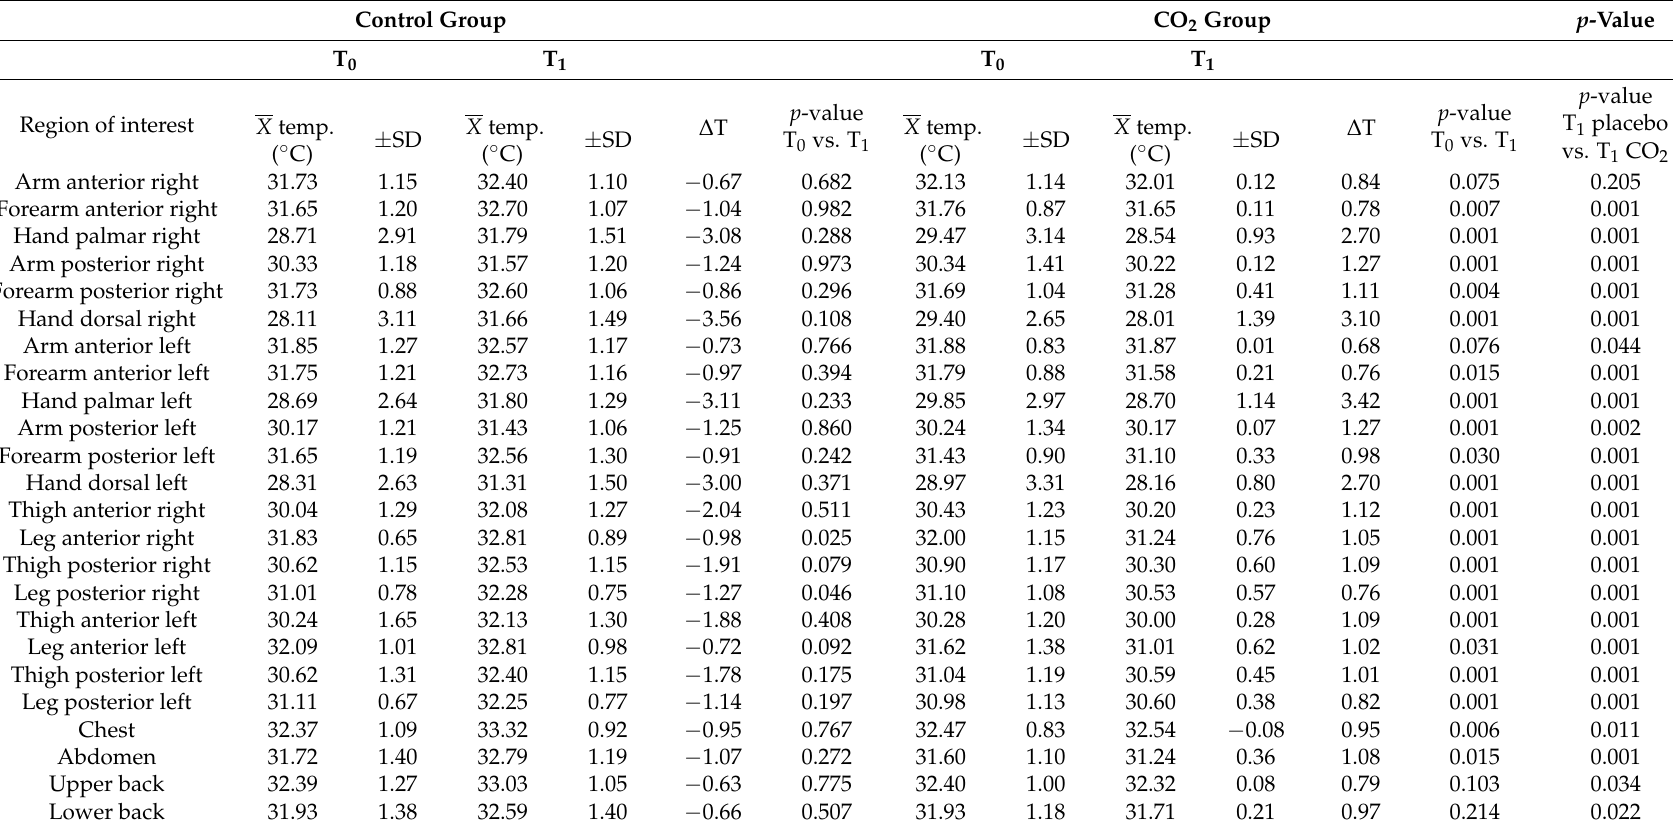
Table 3. Results of tests of statistical surface temperatures of selected region of interest (ROI) during T 0 and T 1 for the study group and the control group. Control Group CO 2 Group p -Value T 0 T 1 T 0 T 1 p -value p -value ∆ T p -value T 1 placebo Region of interest ∆ T X temp. X temp. X temp. X temp. ± SD ± SD ± SD ± SD T 0 vs. T 1 T 0 vs. T 1 vs. T 1 CO 2 ( ◦ C) ( ◦ C) ( ◦ C) ( ◦ C) Arm anterior right 31.73 0.205 Forearm anterior right 31.65 0.001 Hand palmar right 28.71 0.001 Arm posterior right 30.33 0.001 Forearm posterior right 31.73 0.001 Hand dorsal right 28.11 0.001 Arm anterior left 31.85 0.044 Forearm anterior left 31.75 1.21 32.73 0.001 Hand palmar left 28.69 0.001 Arm posterior left 30.17 Forearm posterior left 31.65 Hand dorsal left